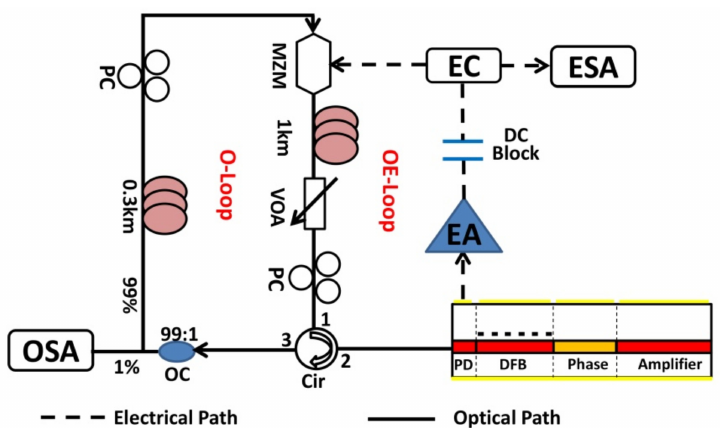
Figure 4. Schematic diagram of the optoelectronic oscillator (OEO) based on the integrated laser-photodetector chip. EA, electrical amplifier; OC, optical coupler; EC, electrical coupler; Cir, circulator; MZM, Mach-Zehnder modulator; PC, polarization controller; VOA, variable optical attenuator; OSA, optical spectrum analyzer; ESA, electrical spectrum analyzer.